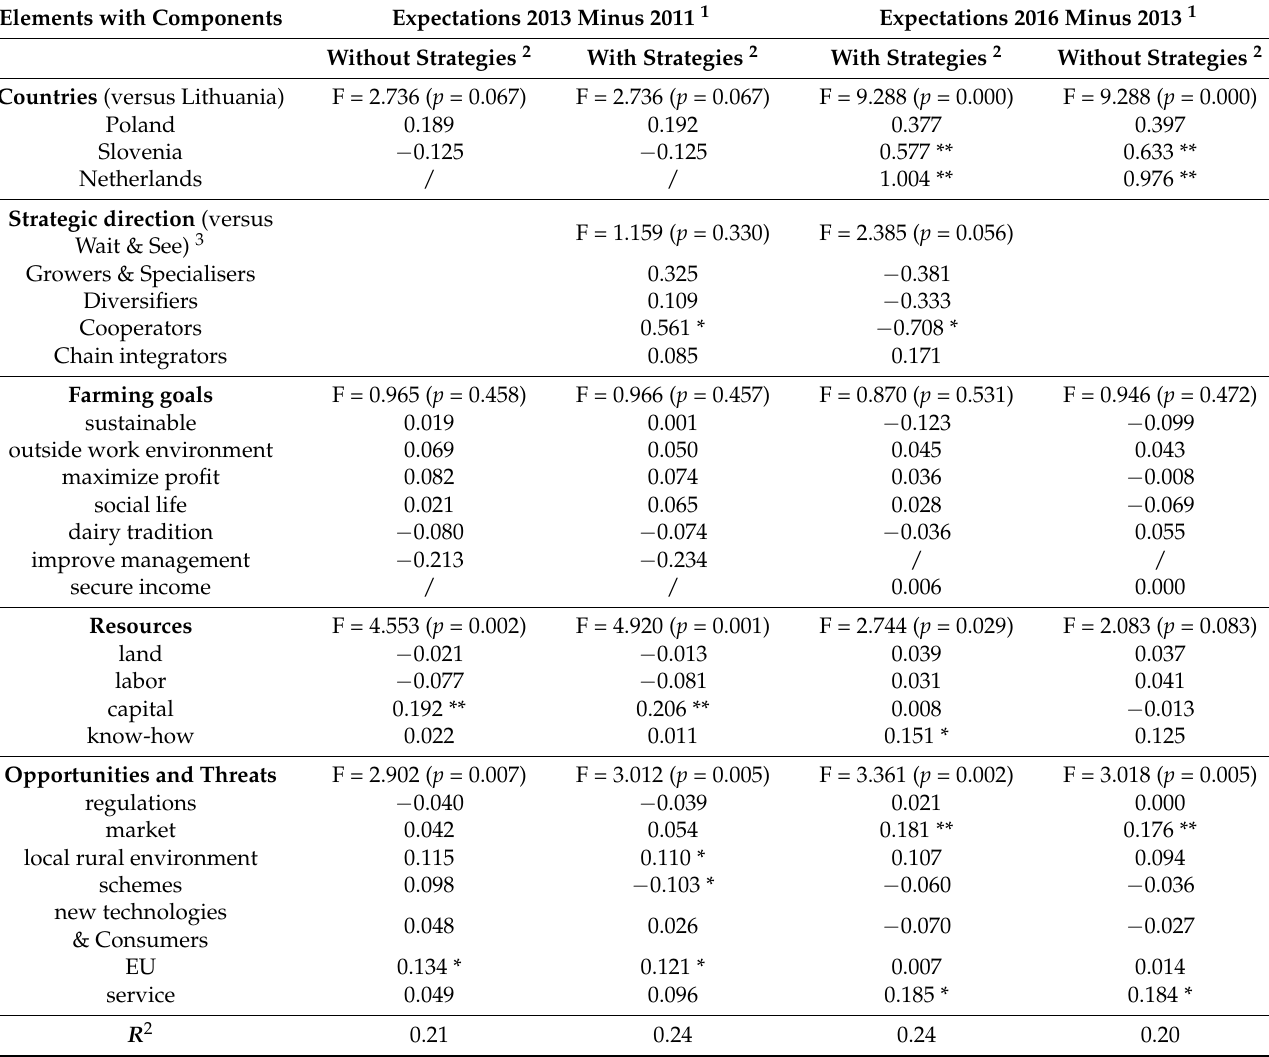
Table 7. Regression analyses of Farming goals, Resources, and Opportunities and Threats on Future prospects for mean 2013 minus 2011 and mean 2016 minus 2013; regression coefficients (b) are listed as the change in performance per unit change in the particular component; strategic direction and countries were inserted as dummy